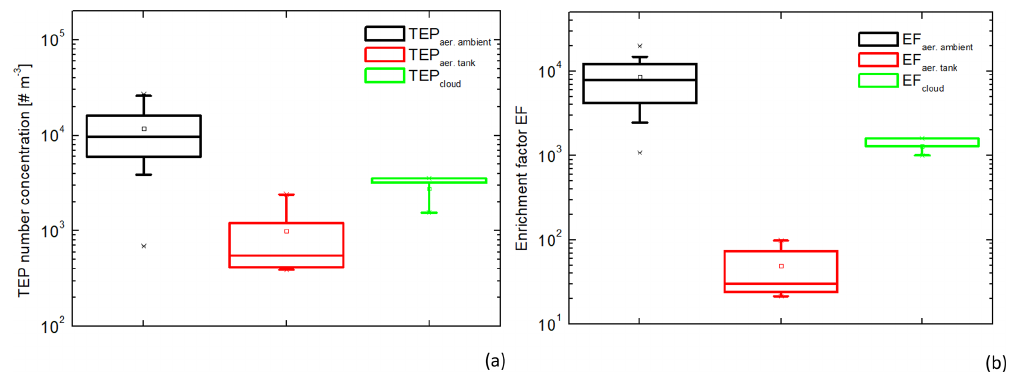
Figure 3. Box and whisker plot of the transparent exopolymer particle (TEP) number concentrations (a) and the enrichment factors (b) in the ambient ( n = 18) and tank-generated ( n = 4) aerosol particles and in the cloud water samples ( n = 3). Each box encloses 50% of the data with the mean value represented as an open square and the median value represented as a line. The bottom of the box marks the 25% limit of the data, whereas the top marks the 75% limit. The lines extending from the top and bottom of each box are the 5% and 95% percentiles within the data set, whereas the asterisks indicate the minimum and maximum